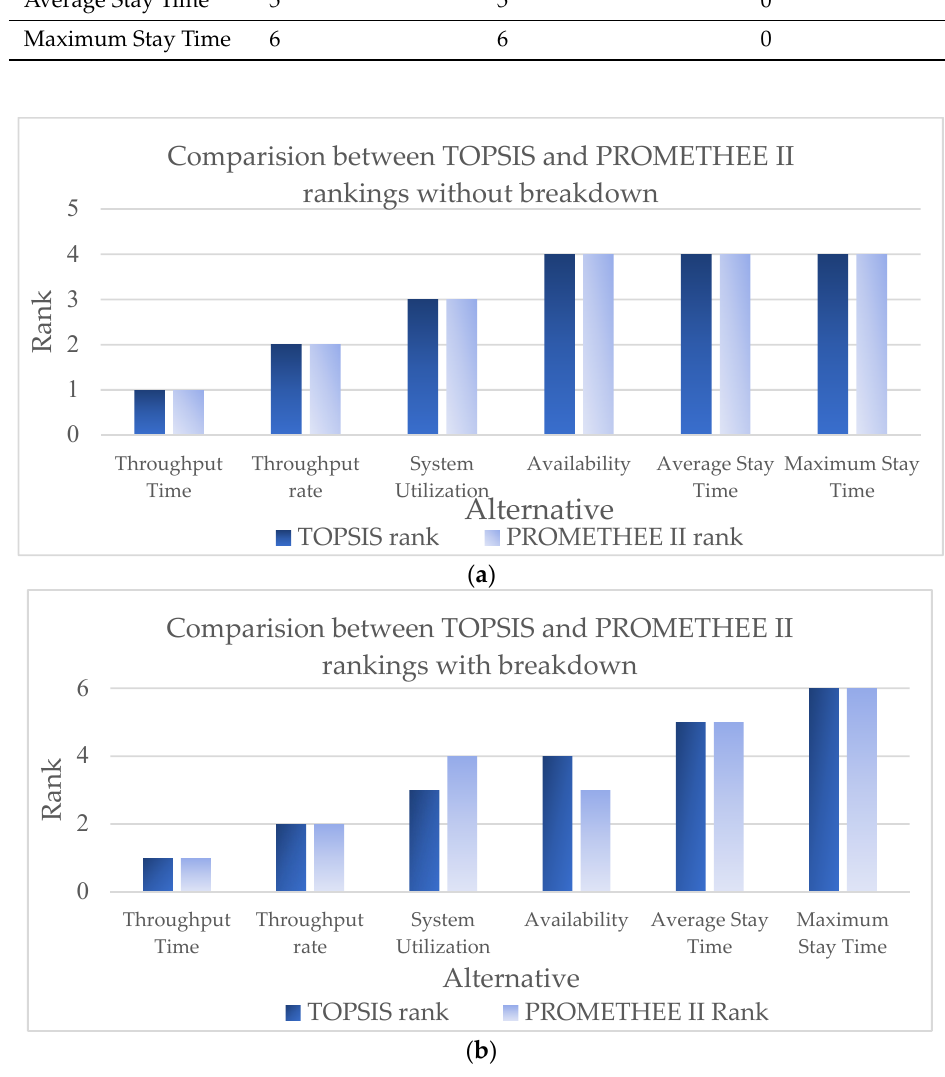
Figure 8. ( a ) Ranking comparison between TOPSIS and PROMETHEEE II method without break- down. ( b ) Ranking comparison between TOPSIS and PROMETHEEE II method without break- down.